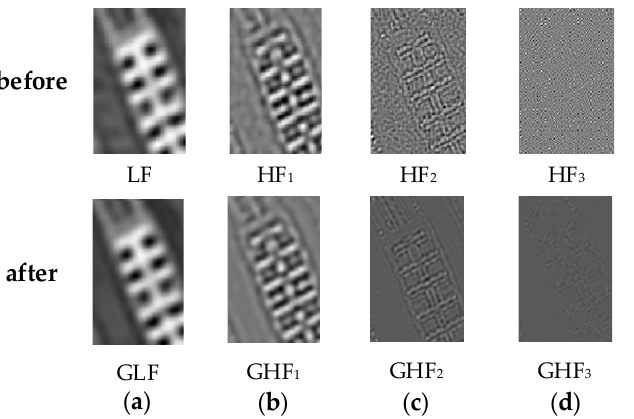
Figure 3. Four components’ images before and after application of the Gaussian filter on Pavia University image block: ( a ) LF to GLF; ( b ) HF 1 to GHF 1 ; ( c ) HF 2 to GHF 2 ; ( d ) HF 3 to GHF 3 .